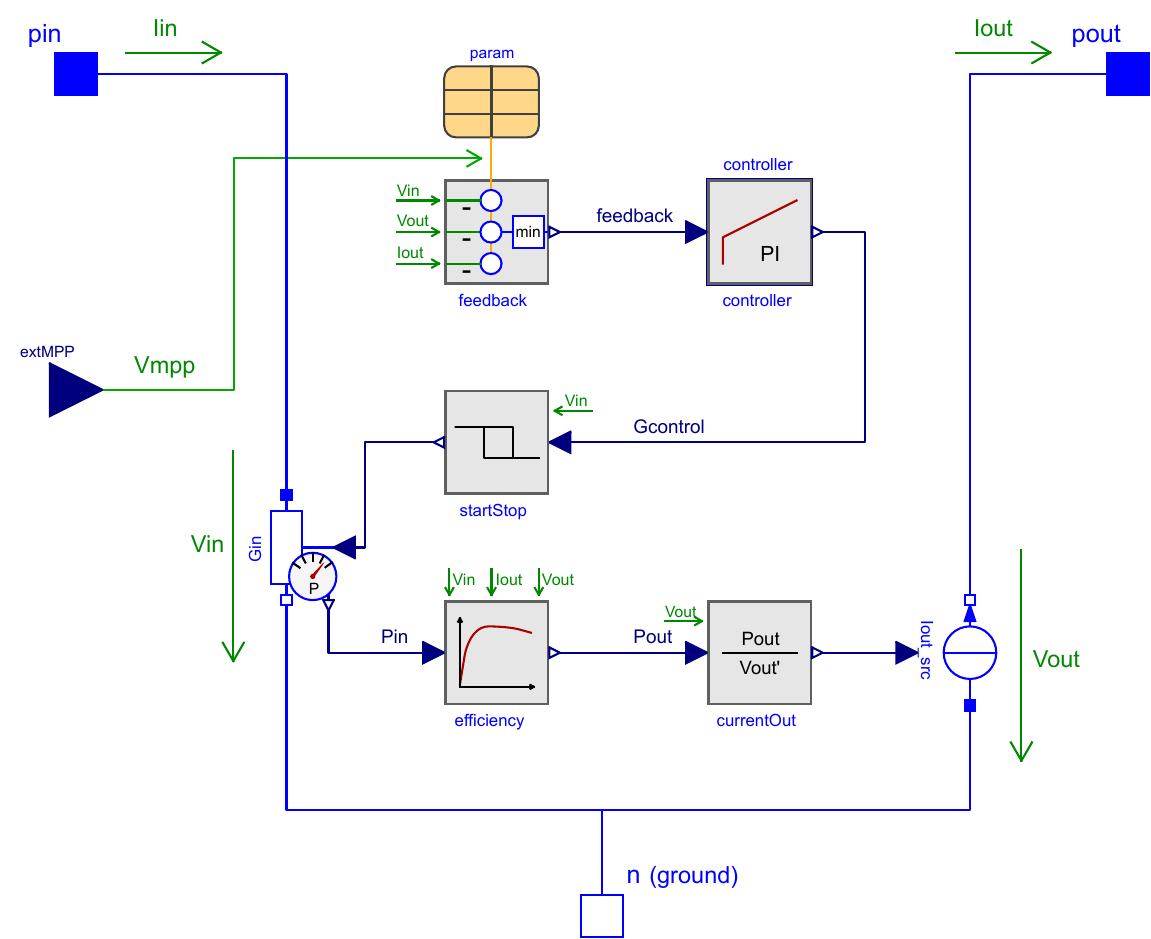
Figure 2. Internal structure of the proposed power converter model implemented in Modelica. The model uses components such as a conductor and a current source and new components depicted as gray blocks. The green labels are global variables that are available in all components. The blocks itself contain only equations and no further Modelica